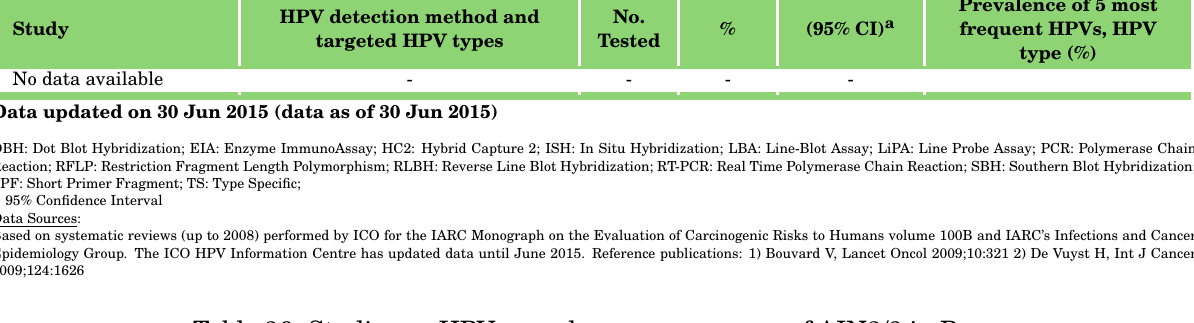
Table 26: Studies on HPV prevalence among cases of AIN2/3 in Peru